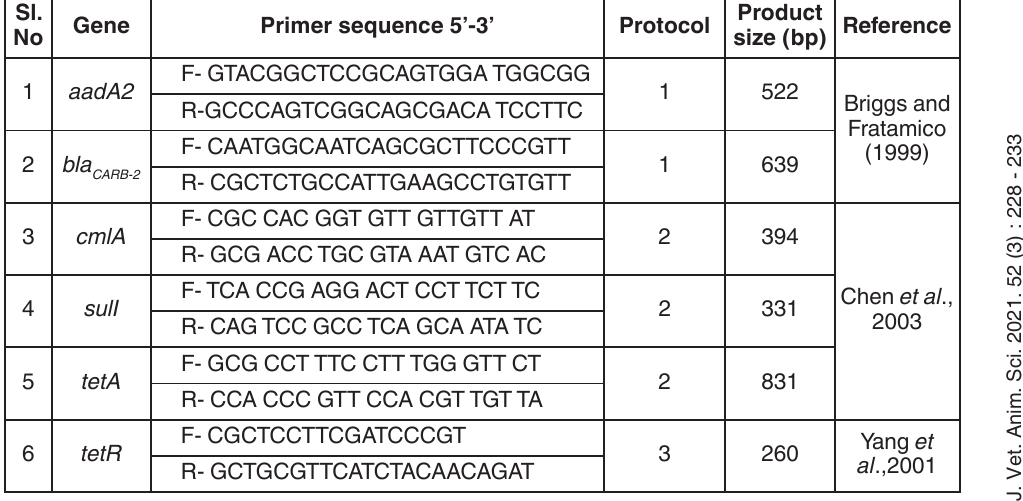
table 1: Primers used for the molecular characterization of the isolates sl.